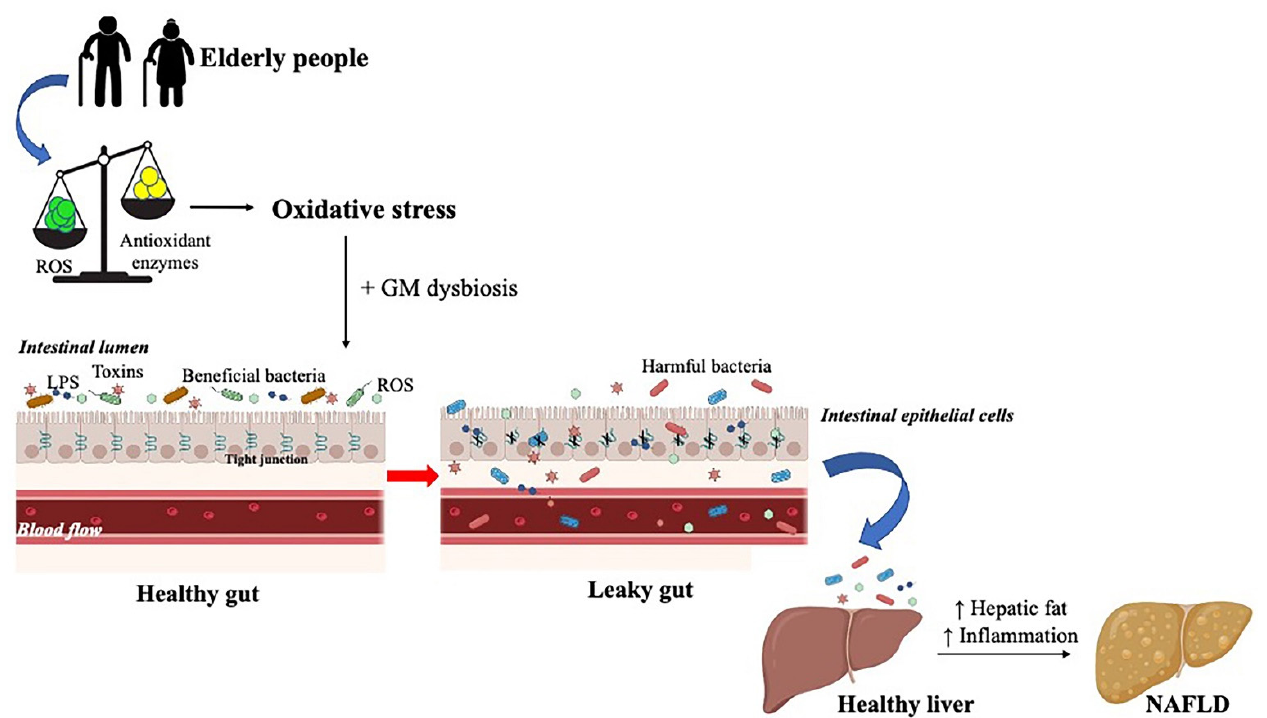
Figure 2. ”Leaky gut” syndrome contributes to the onset of NAFLD. In the elderly, the imbalance between the formation of ROS and the presence of antioxidant enzymes leads to oxidative stress, which, at the intestinal level contributes to gut microbiota (GM) dysbiosis. These two conditions disrupt the tight junctions of the epithelial cells, resulting in the translocation of endotoxins, lipopolysaccharides (LPS), harmful bacteria, and ROS from the intestinal lumen into the blood circulation where they are taken up by the liver and cause an increase in lipogenesis and inflammation, finally resulting in the development of this hepatic disease.